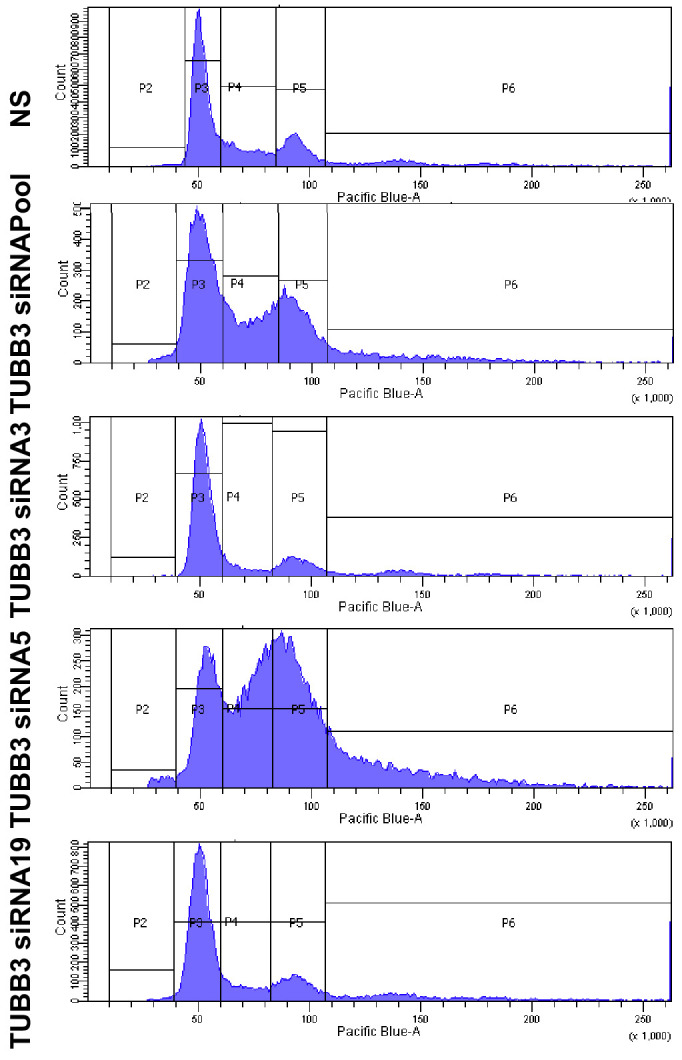
Representative flow cytometry histograms of cell cycle analysis of BT-20 cells after transfection with specific TUBB3 siRNAs.